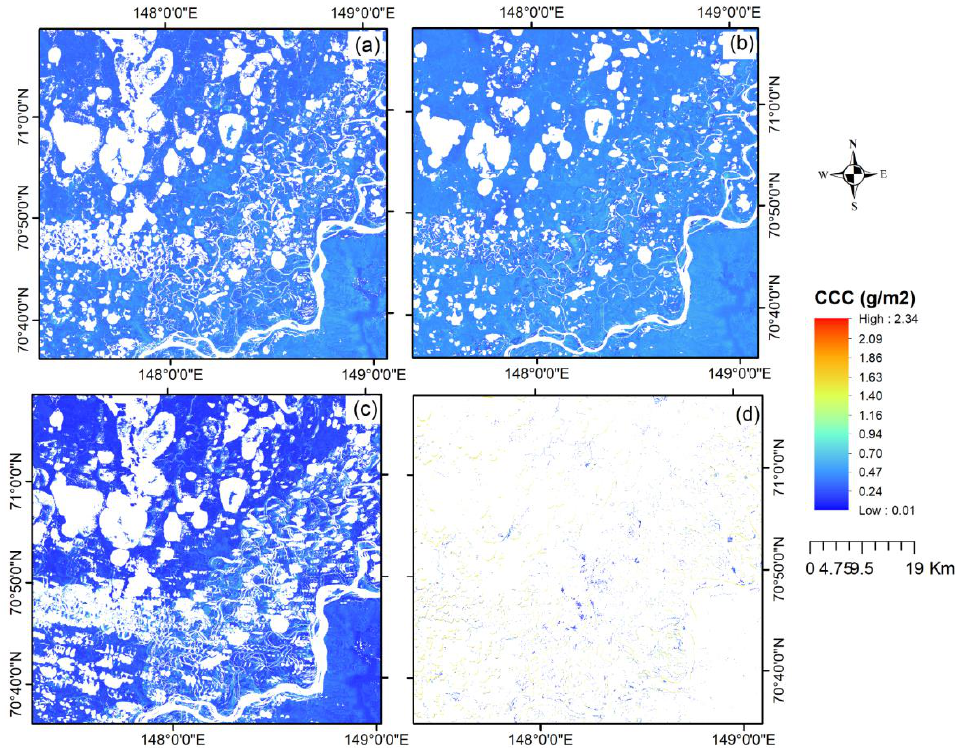
Figure 5. CCC products estimated from the Sentinel-2 image of 21 May 2018, using the SNAP toolbox ( a ), SRVI ( b ), PROSAIL inversion by LUT ( c ), and PLSR ( d ) for the Kytalyk Arctic tundra pilot site. The two-sample Kolmogorov-Smirnov test among pairs of CCC products from INFORM, SRVI, and SNAP did not show significant distribution disparities in the temperate forest pilot site (Table 5).